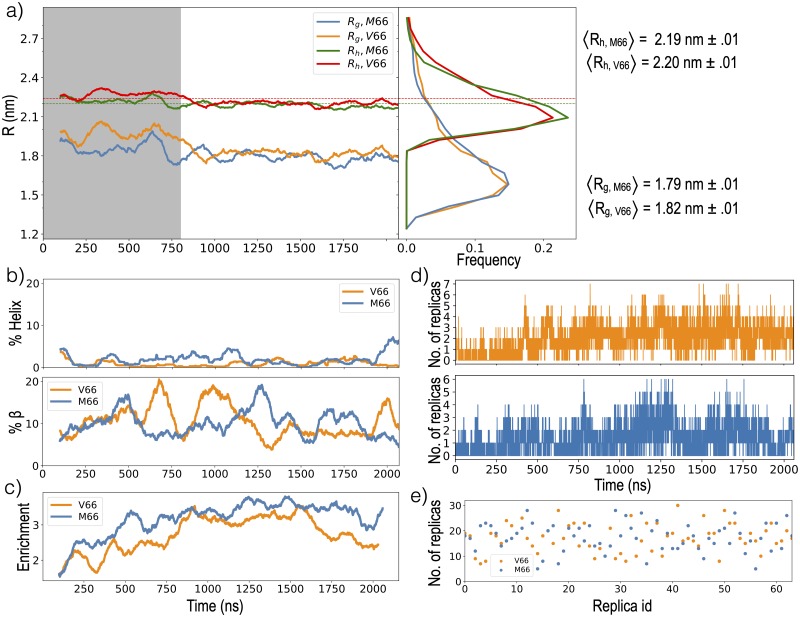
Simulation convergence.a) Trajectory (left) and distribution (right) of Rg and Rh for the 300K replicas. The shaded region represents the equilibration period discarded from the distribution and from all analysis presented in Results and Discussion. Experimental values of Rh from NMR diffusion [63] are 2.24±0.1 nm for the V66 sequence and 2.20±0.1 nm for the M66 sequence, and are indicated by dashed lines. b) Trajectory of helix (top) and β (bottom) propensity at residue 66 for the 300K replicas of both sequences. c) Trajectory of enrichment of total Region I-Region III contacts relative to SAHP in the 300K replica. The trajectory shows averages over a 100 ns moving window in panel a, b and c. d) Number of replicas forming the V66-V94 contact (top) and the M66-M95 contact (bottom) vs the simulation time. e) The number of round trips completed by each replica over the 1.2 μs production period.